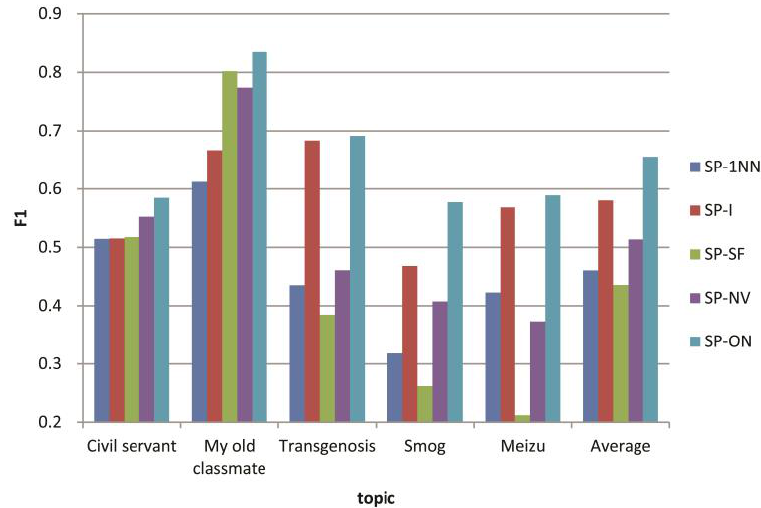
Figure 1. Running performance of post clustering (the threshold is 0.035).